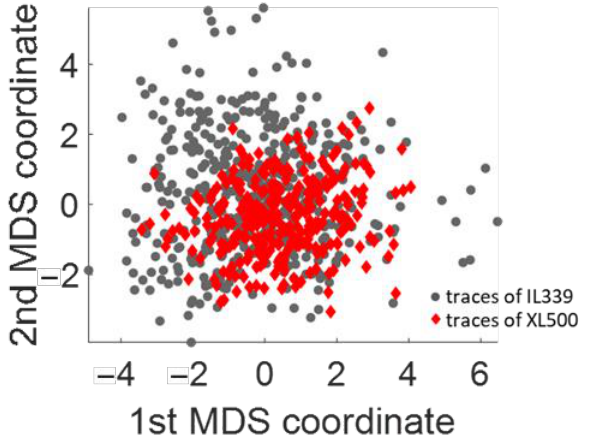
Figure 4. MDS plot comparing the IL339 with the XL500. Grey dots are traces of the IL339 and red dots are traces of the XL500. dots are traces of the